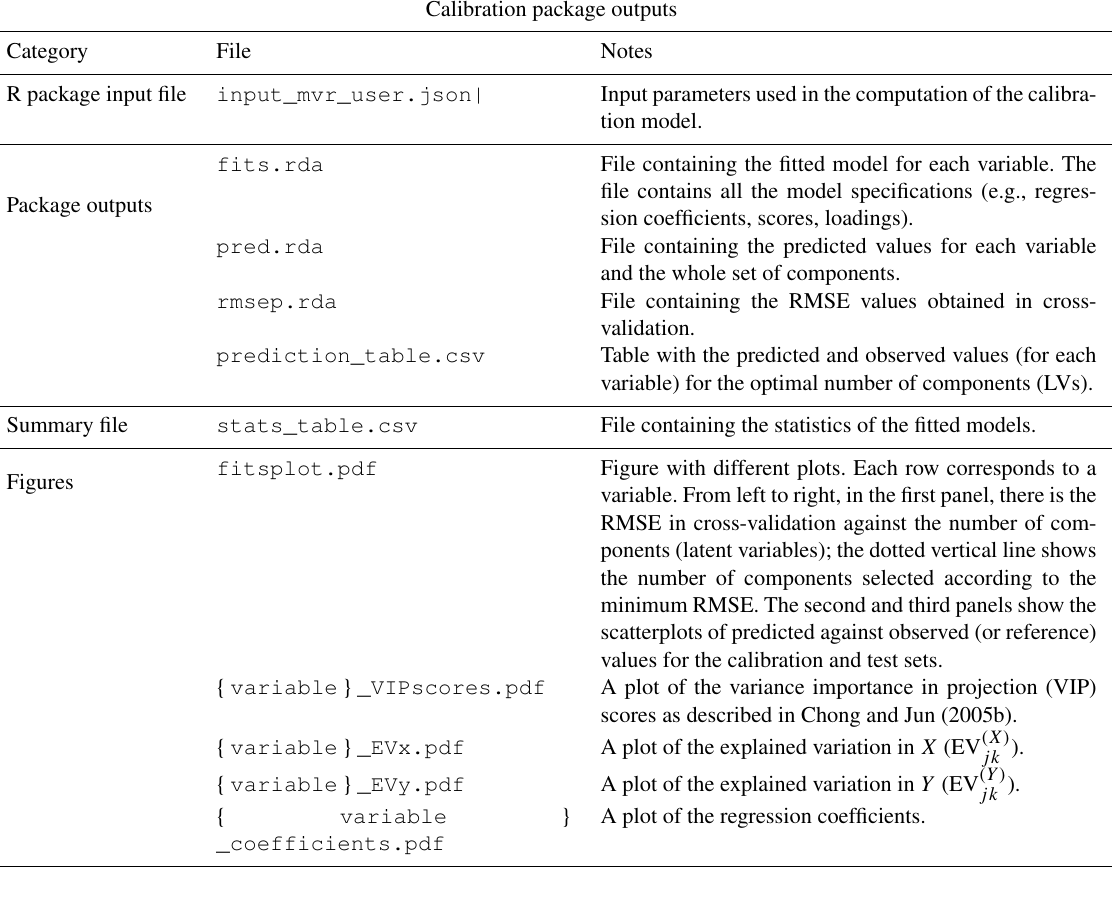
Table 4. List of outputs of the calibration chemometric package.